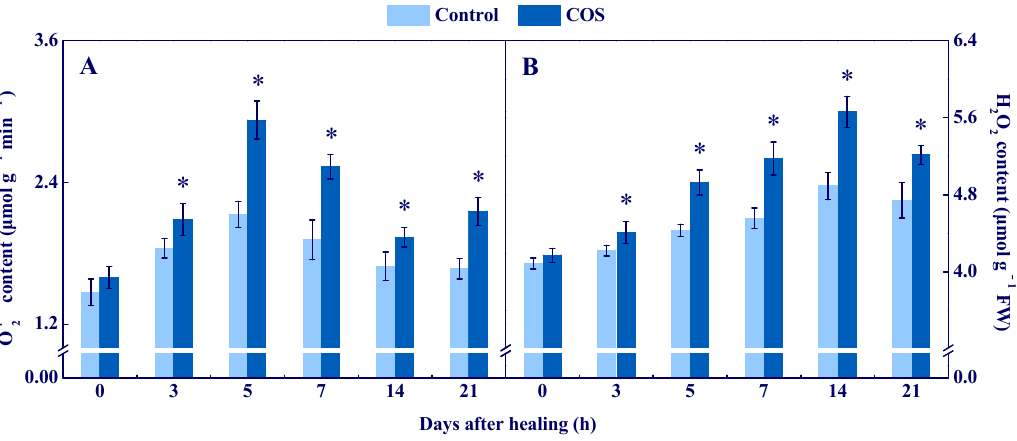
Figure 2. Effect of COS treatment on the contents of O 2 ●− ( A ) and H 2 O 2 ( B ) at wounds of potato tubers during healing. Bars indicate standard error. Asterisks denote significant differences ( p < 0.05). These results suggested that COS activated NOX and SOD, and enhanced the contents of O 2 ●− and H 2 O 2 at tuber wounds.